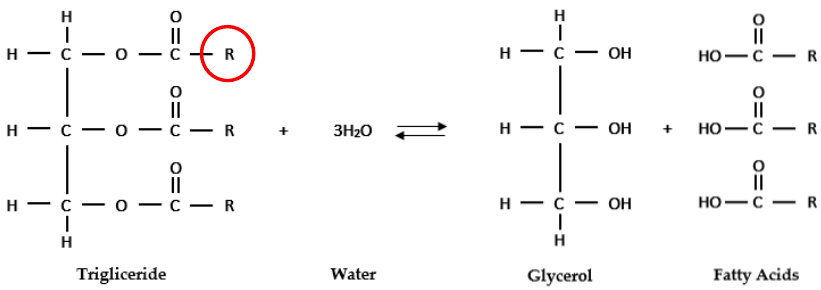
Figure 6. Hydrolysis reaction of natural ester .